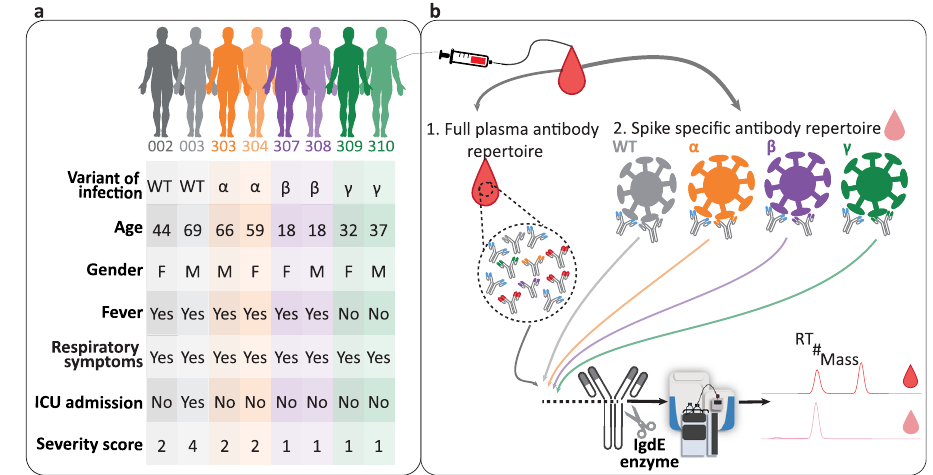
Fig. 1 | Donor Characteristics and Monitoring of individual full IgG1 and S-protein antigen directed IgG1 pro fi les. a Overview of the donors, who had experienced an infection by the named VOCs. VOCs are color-coded with WT (gray), Alpha (orange), Beta (purple) and Gamma (green). The table also lists age, gender,anddiseasestateincludingFever,respiratorysymptomsandintensivecare unit (ICU) admission following the World Health Care (WHO) severity score. b For each plasma sample taken we analyzed the full plasma IgG1 antibody repertoire as well as the antigen directed IgG1 clones to the four different VOCs S-proteins.